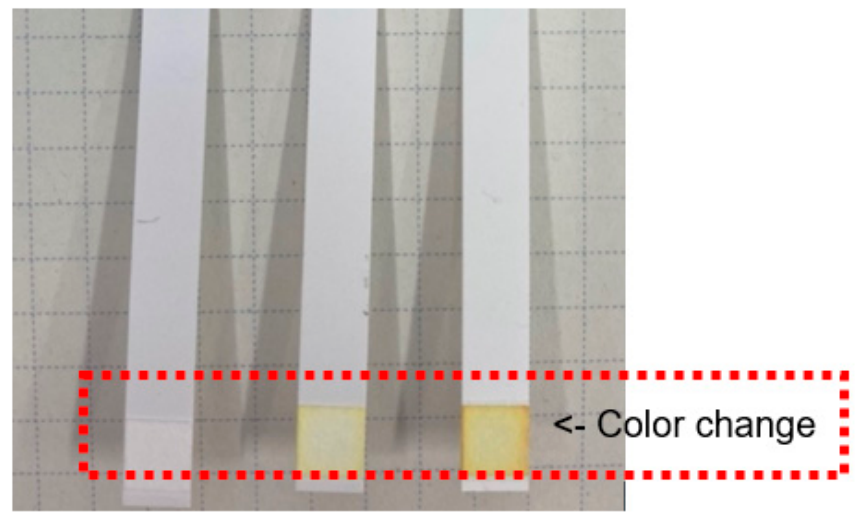
Figure 4. Photograph of the test paper for higher arsenic contents in the presence of different levels of arsenic in the water samples.